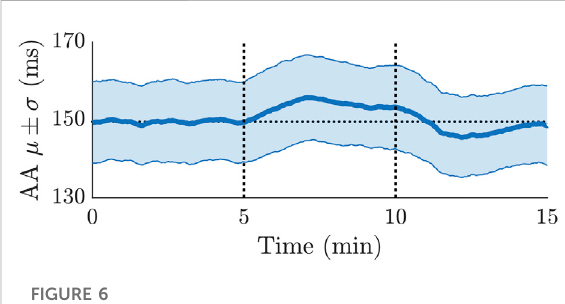
FIGURE 6 Averaged mean and standard deviation of the AA series estimatedfromECGrecordingsof24patients.The fi rst5 minwere during supine position, followed by 5 min of HDT and 5 min of HUT. The horizontal dotted line illustrates the average of the μ trend during the fi rst 5